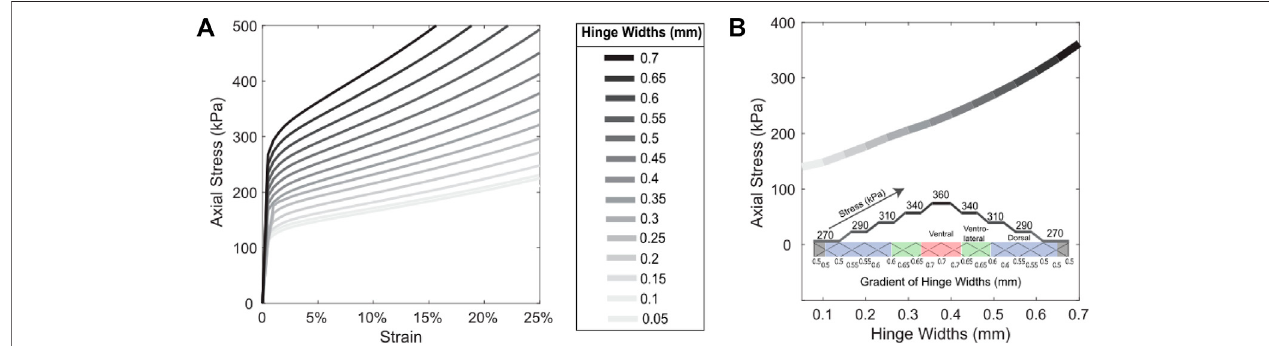
FIGURE 3 | (A) In-plane scale rotation for each skin under bending: (i) rectilinear achieves bending through the non-ideal behavior of the kirigami material that can strain and twist out-of-plane, (ii) curvilinear lattice with inherent hinge gradient, (iii) curvilinear lattice with additional circumferential translation of scale tip further decrease θ , (iv) polar lattice where scales actually over-rotate at the largest bend angle. (B) Normalized pressure-bend angle relationship.